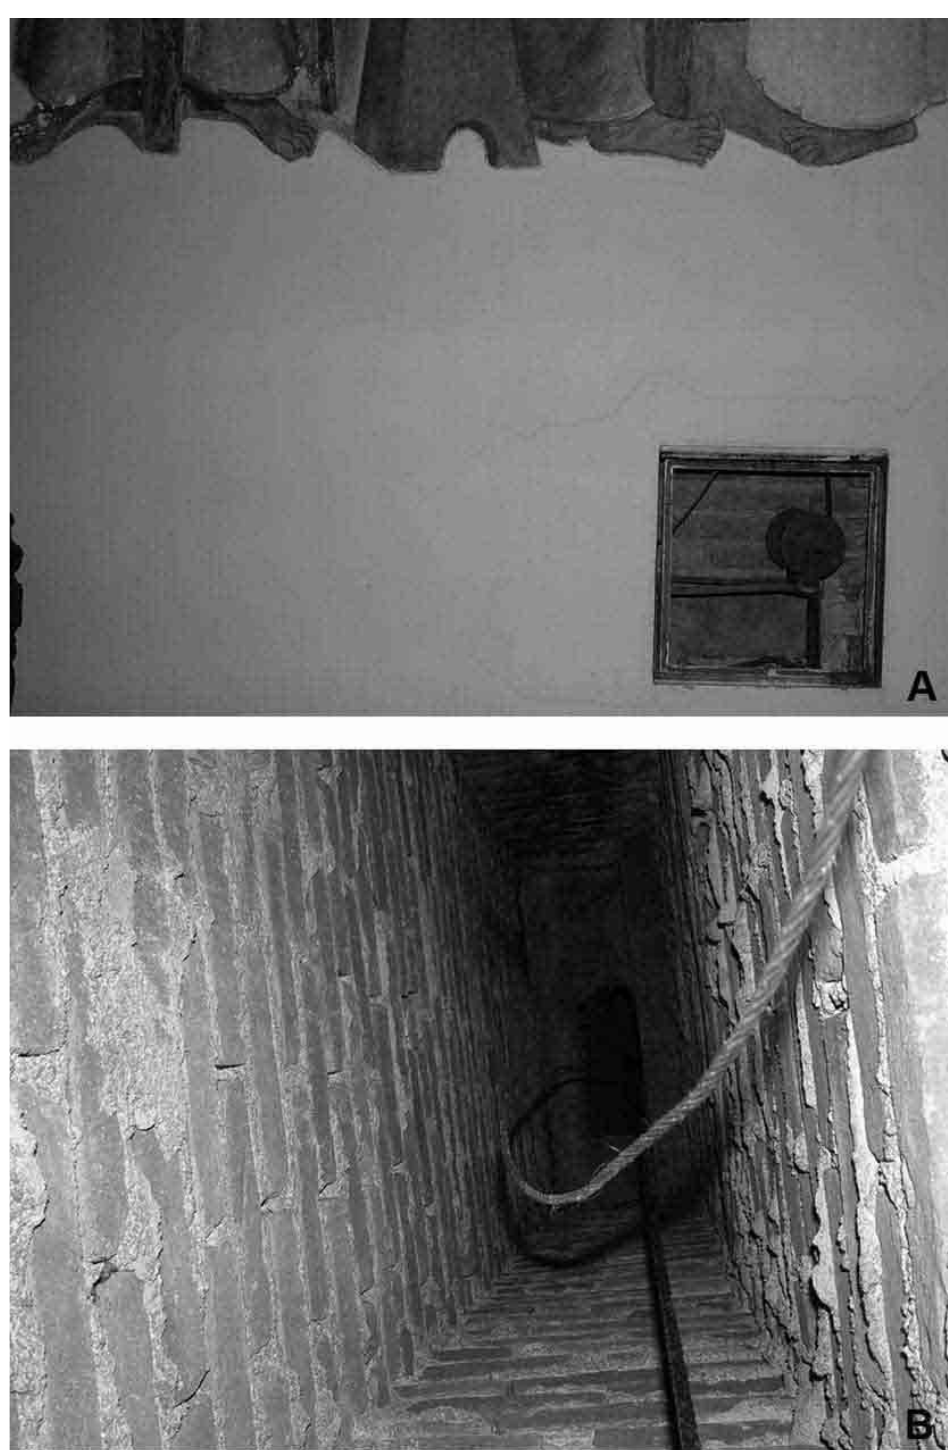
Fig. 5 – Bottom of fresco Supper at Emmaus and perpendicular view of false wall (A). False wall between the outer wall of the Chapel and the frescoed wall